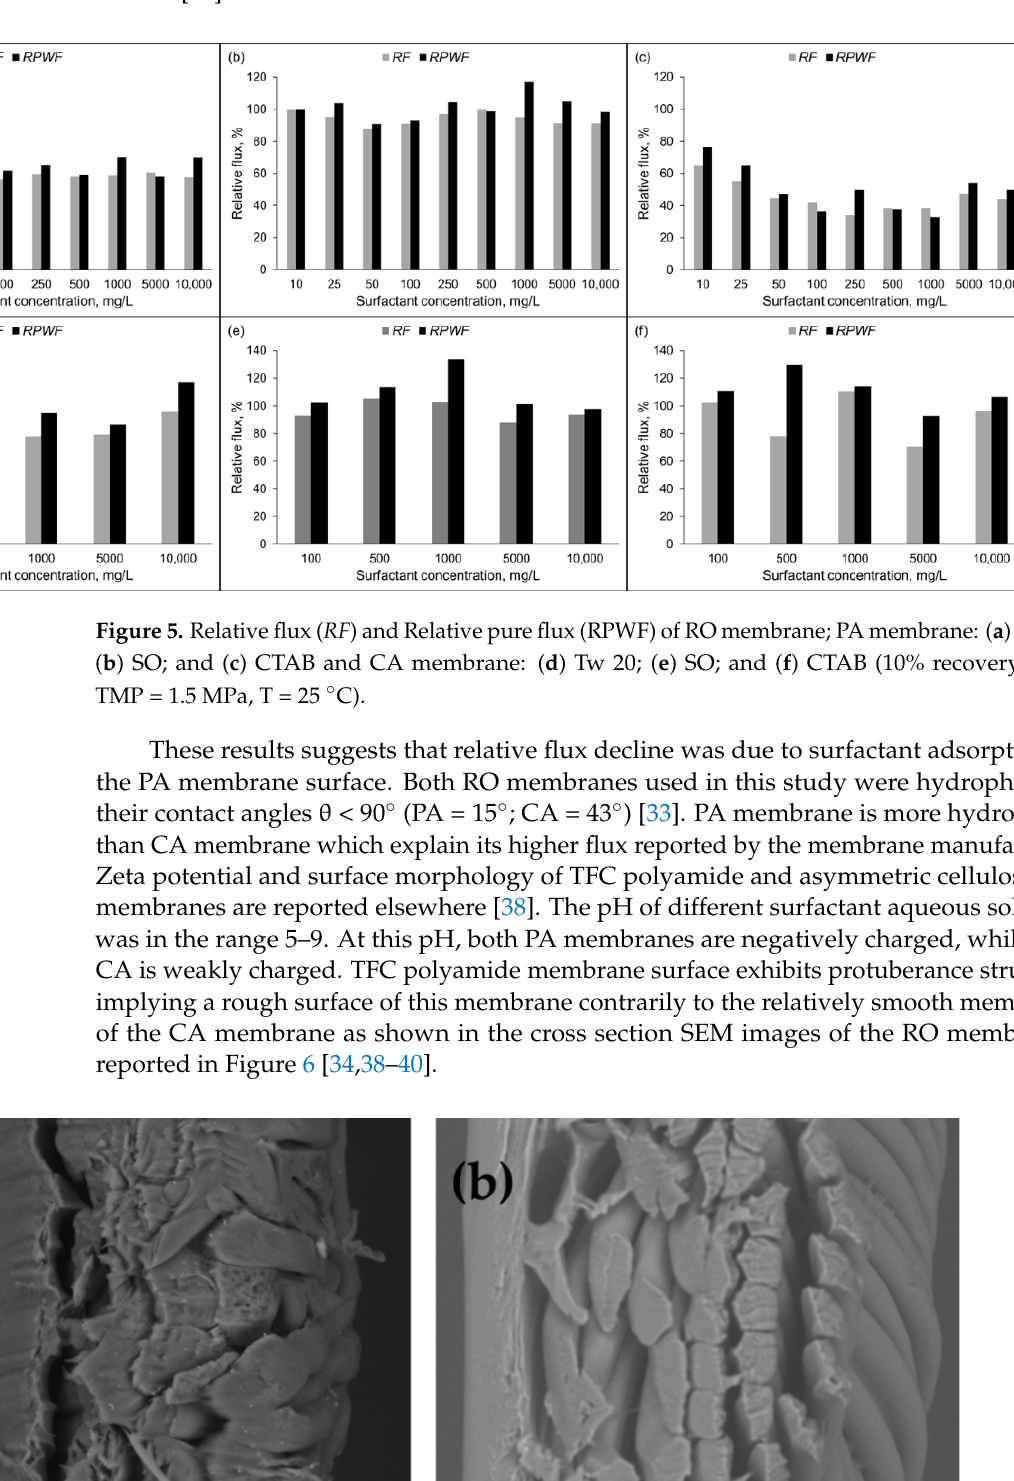
Figure 6 . SEM images of cross section of PA ( a ) and CA ( b ) membranes.